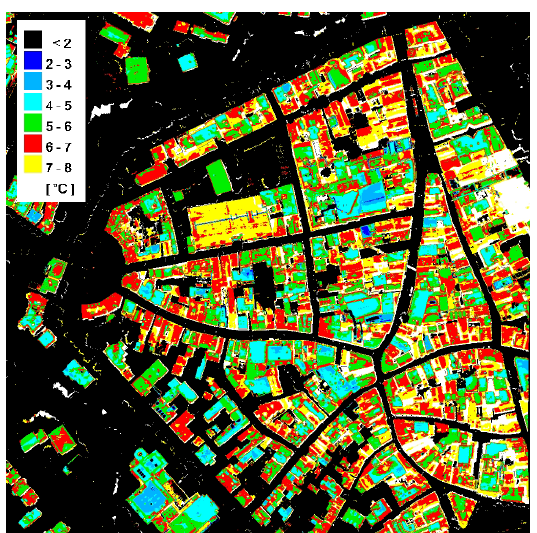
Figure 5: Individual temperature differences of the city buildings of Oldenburg extracted from hyperspectral, laserscan, and thermal data using a decision tree algorithm, 500 m x 500 m